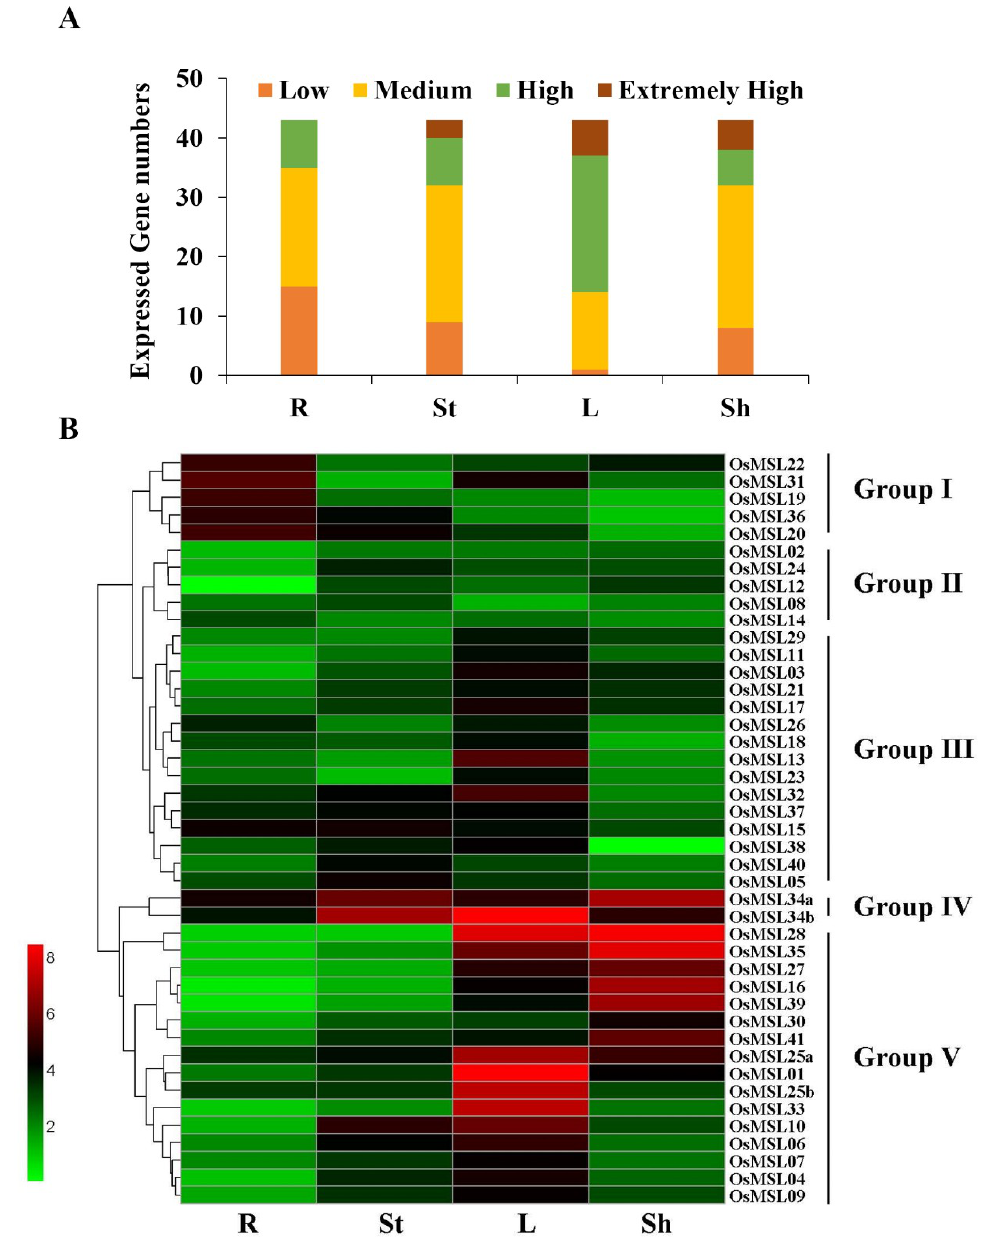
Figure 8. Expression of the rice trihelix gene family in various tissues (R: Root; St: Stem; L: Leaf; Sh: Sheath). ( A ) Numbers of expressed genes in each tissue. Expression data of the rice trihelix gene family were retrieved from the Expression Atlas database. Extremely high: Expression value > 6, high: 6 ≥ expression value > 4, medium: 4 ≥ expression value > 2, low: 2 ≥ expression value > 0; ( B ) Expression patterns of the trihelix genes in various rice tissues. Heatmaps were created in HemI v.1.0 and based on the expression data. Expression levels are depicted by different colors on the scale. Green and red represent low and high expression levels, respectively.